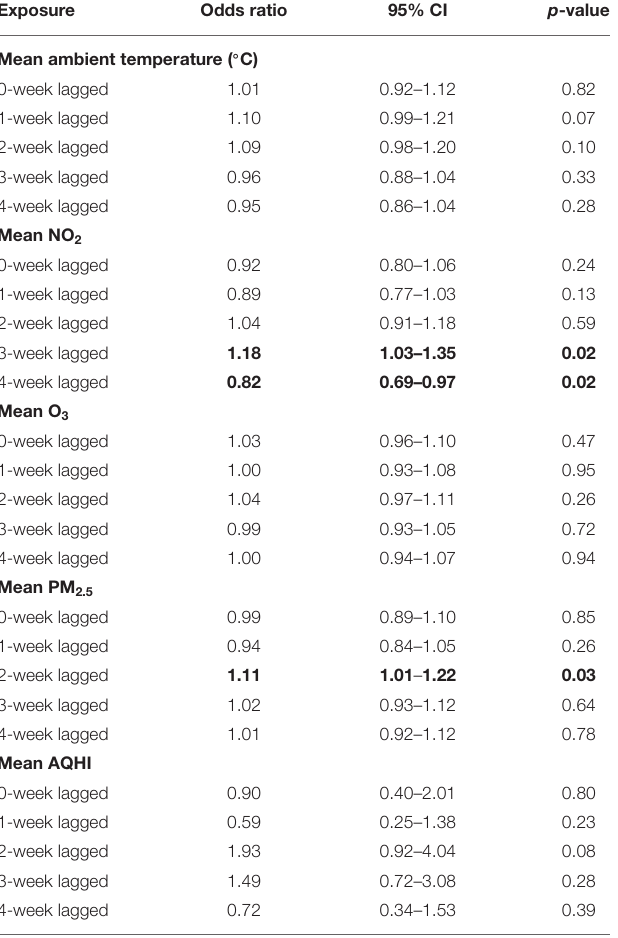
TABLE 4 | Final multivariable model results showing the associations between weekly average ambient exposures and increased proportions of lower airway granulocytes ( n = 78,